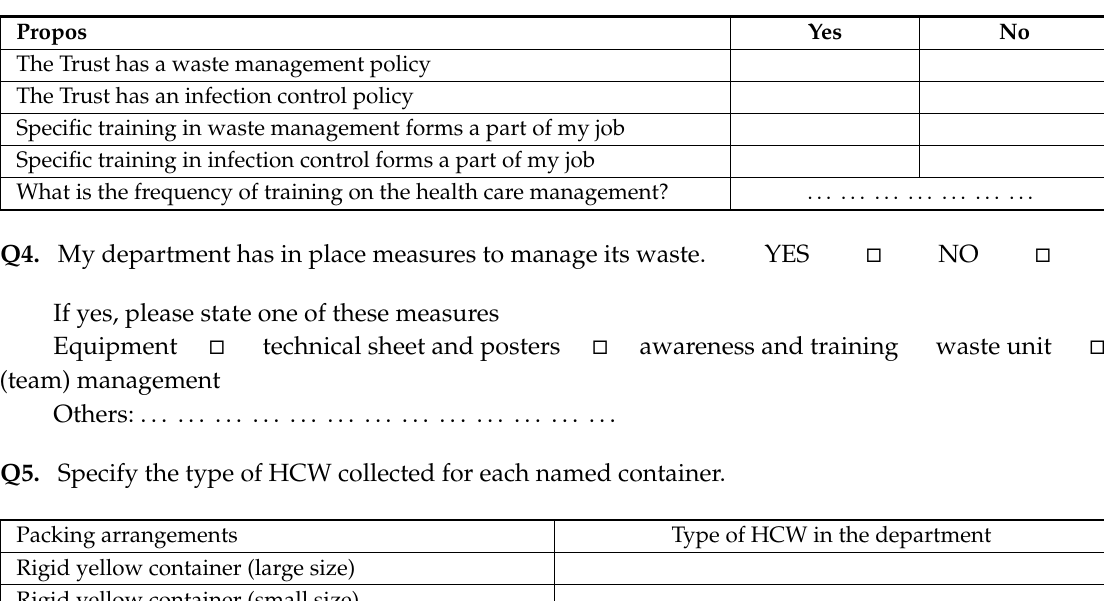
Packing arrangements Type of HCW in the department Rigid yellow container (large size) Rigid yellow container (small size) Cartons with yellow bags Freezer Black